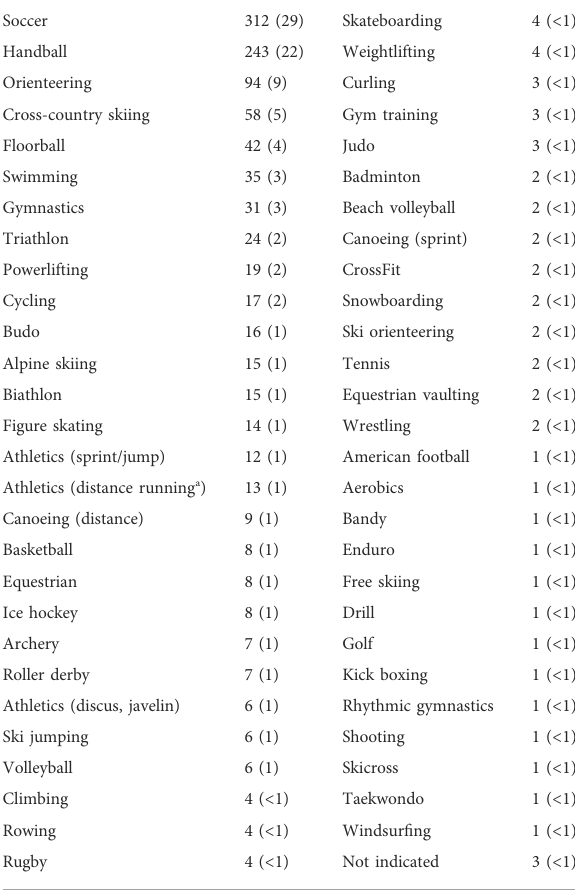
TABLE 1 The number (percentage) of respondents participating in different